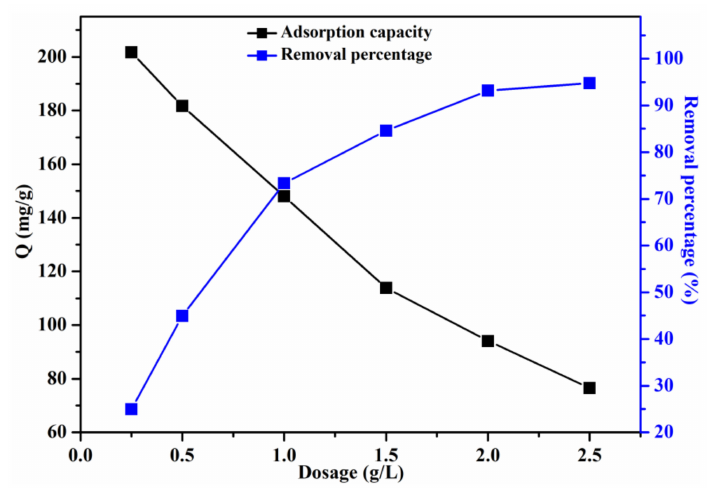
Figure 8. Effect of dosage on adsorption capacity and removal percentage (Adsorbed dose = 80 kGy, dose rate = 20 kGy/pass, GMA concentration = 40 wt%, contact time = 24 h, pH = 6, C 0 = 200 mg/L, T = 298.15 K).